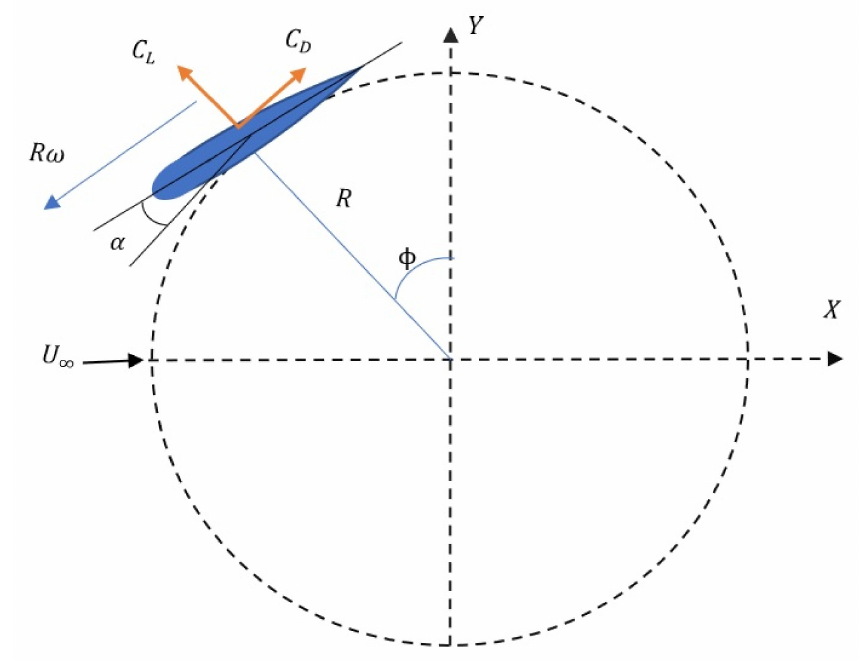
Figure 8. Aerodynamic load of Darrius wind